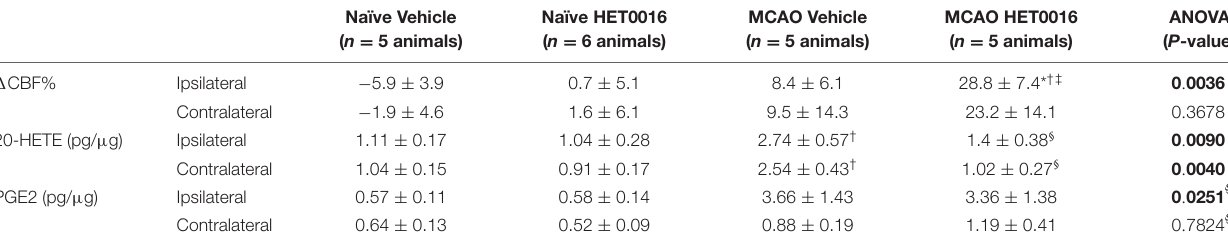
TABLE 1 | Changes in CBF and levels of cortical 20-HETE and PGE2 after vehicle or HET0016 treatment.